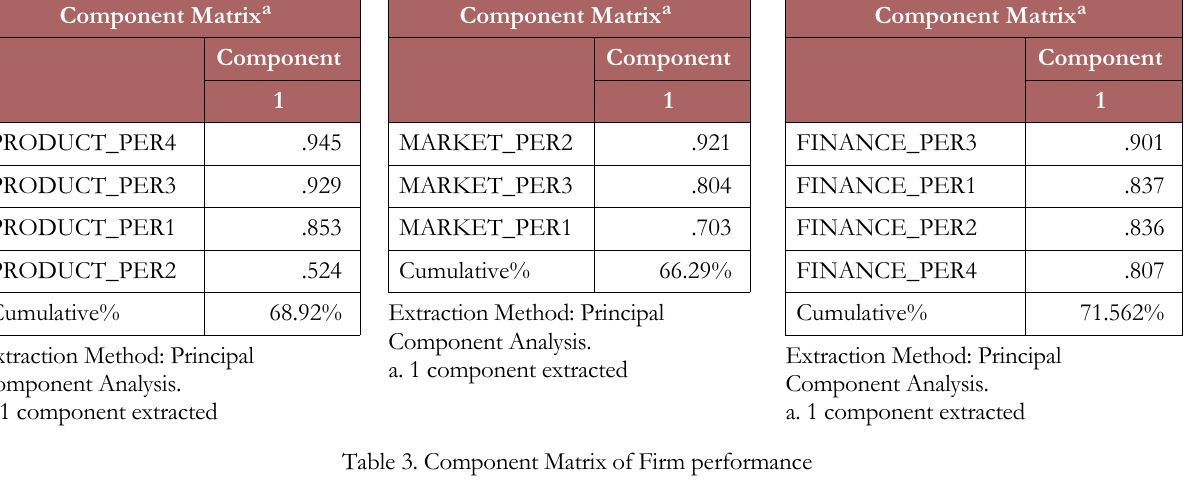
Table 3. Component Matrix of Firm